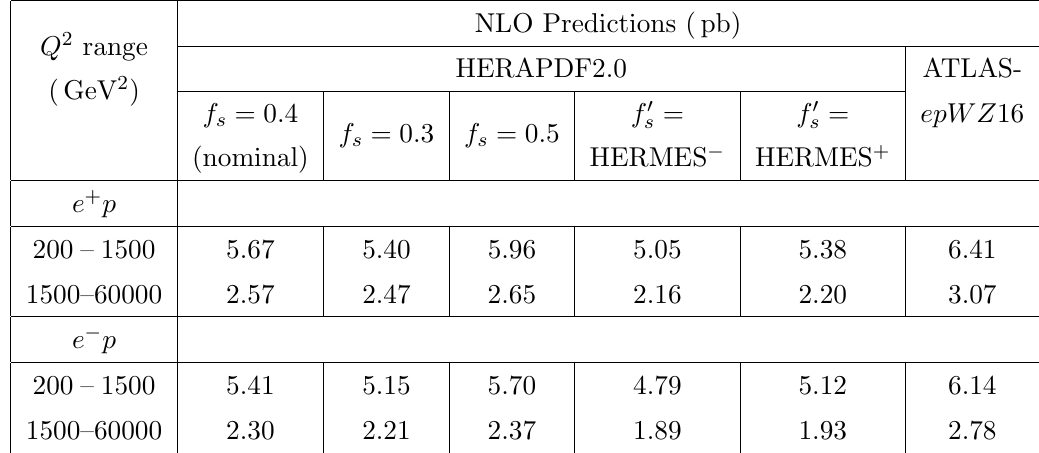
Table 5. The NLO ZM-VFNS predictions with varied strange-quark fraction f s . Additionally, two x -dependent strange quark fractions were used as suggested by the HERMES collaboration. The ZM-VFNS predictions were also evaluated with the ATLAS- epWZ 16 PDF set with an unsuppressed strange-quark